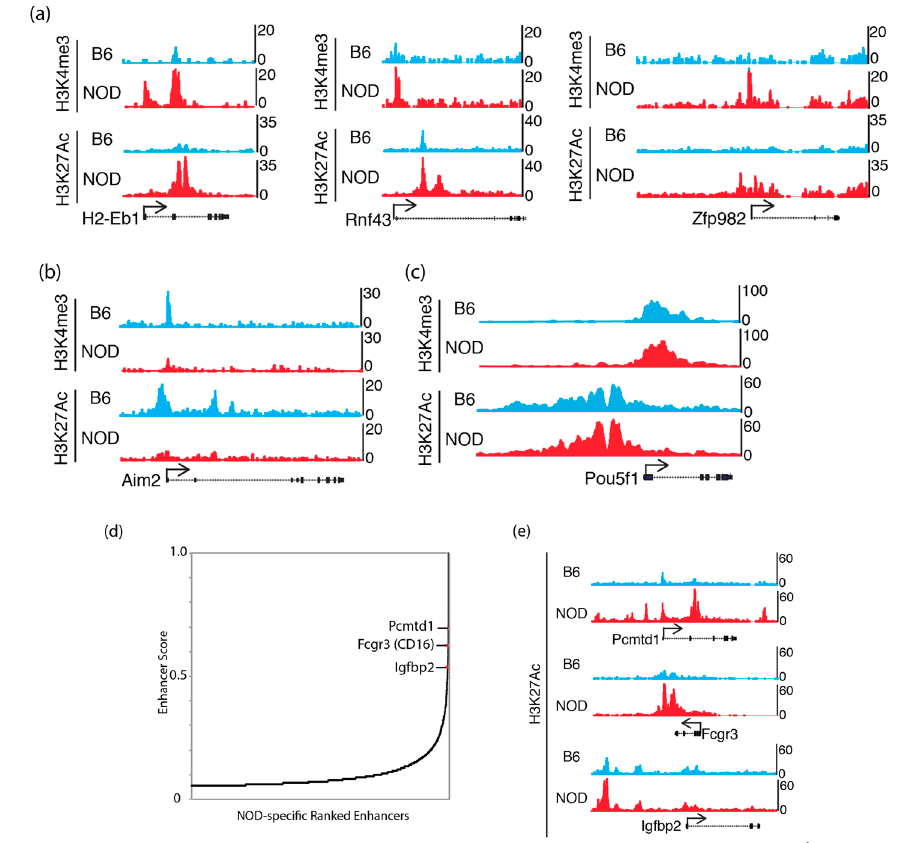
Figure 4. Active chromatin states in NOD and B6 ES cells: UCSC genome browser tracks show H3K4me3 and H3K27ac ChIP-Seq levels that are ( a ) increased at Idd genes: H2-Eb1, Rnf43 and Zfp982 in NOD ES cells; ( b ) increased at Aim2 in B6 ES cells and ( c ) equally enriched at the Pou5f1 (Oct4) promoter in both B6 and NOD ES cells. ( d ) NOD-specific super enhancer analysis using H3K27ac ChIP-Seq signals discovered genes that are implicated in diabetes GWAS studies. ( e ) UCSC genome browser tracks show stronger H3K27ac ChIP-Seq signals at NOD-specific super enhancers compared to B6.